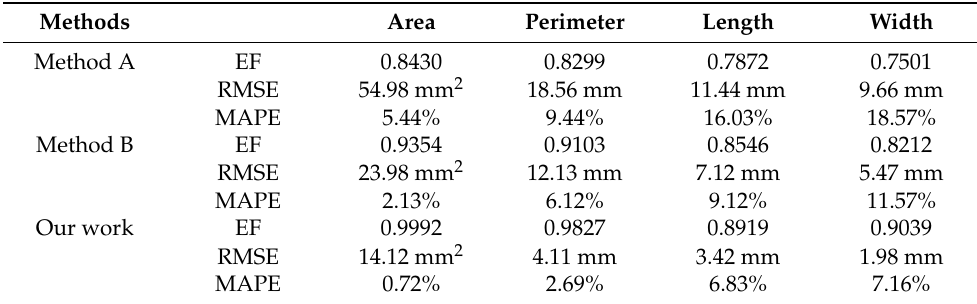
Table 7. Measurement accuracies of the scale-related morphological traits using the Euclidean Clustering method, Facet Region Growing method, and our method.